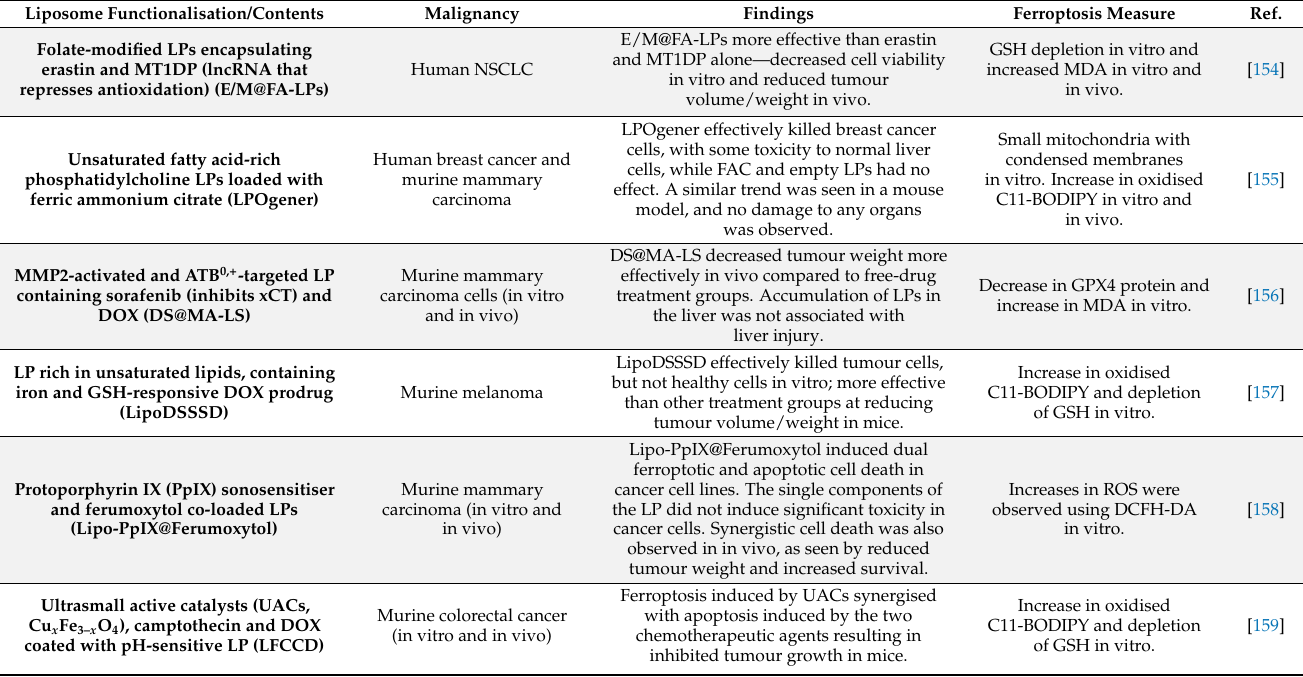
Table 2. Summary of recent liposome technologies aimed at inducing ferroptosis in non- haematological